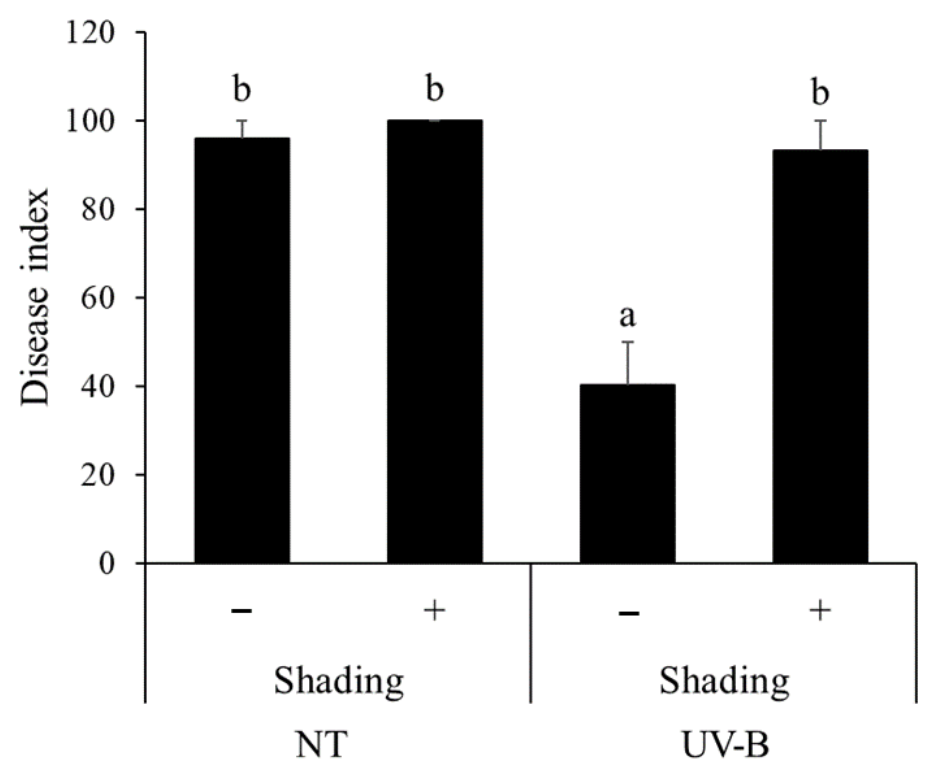
Figure 2. Preventive effect of partial UV-B treatment against powdery mildew in cucumber. NT: non-treatment; shading +: one of two leaves shaded by aluminum foil; shading − : non-shaded leaf. The disease index is based on a 0–4 rating scale applied to the first leaf on each plant 7 d post-inoculation. Different letters above columns indicate a significant difference between treatments. Vertical bars represent the standard error of the mean ( n = 6; Tukey’s test, p <